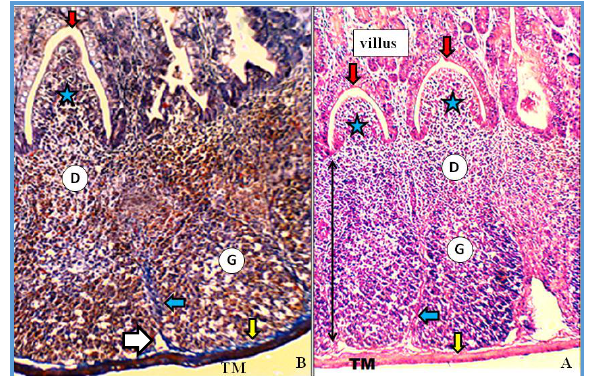
Figure, 2: (A) Wall of SR at 15 days of age showed typically 4 tunicae. Not the crescent hallows above the dome-shaped (blue stars), thick lamina propria (double heads arrow) contains diffuse (D) and follicular lymphatic tissue with germinal center (G), tunica muscularis (TM) and thin submucosa (yellow arrow) from which extend the septa (blue arrows) and blood vessel (white arrow). A: H and E, X100, B: Mallory Trichrome,